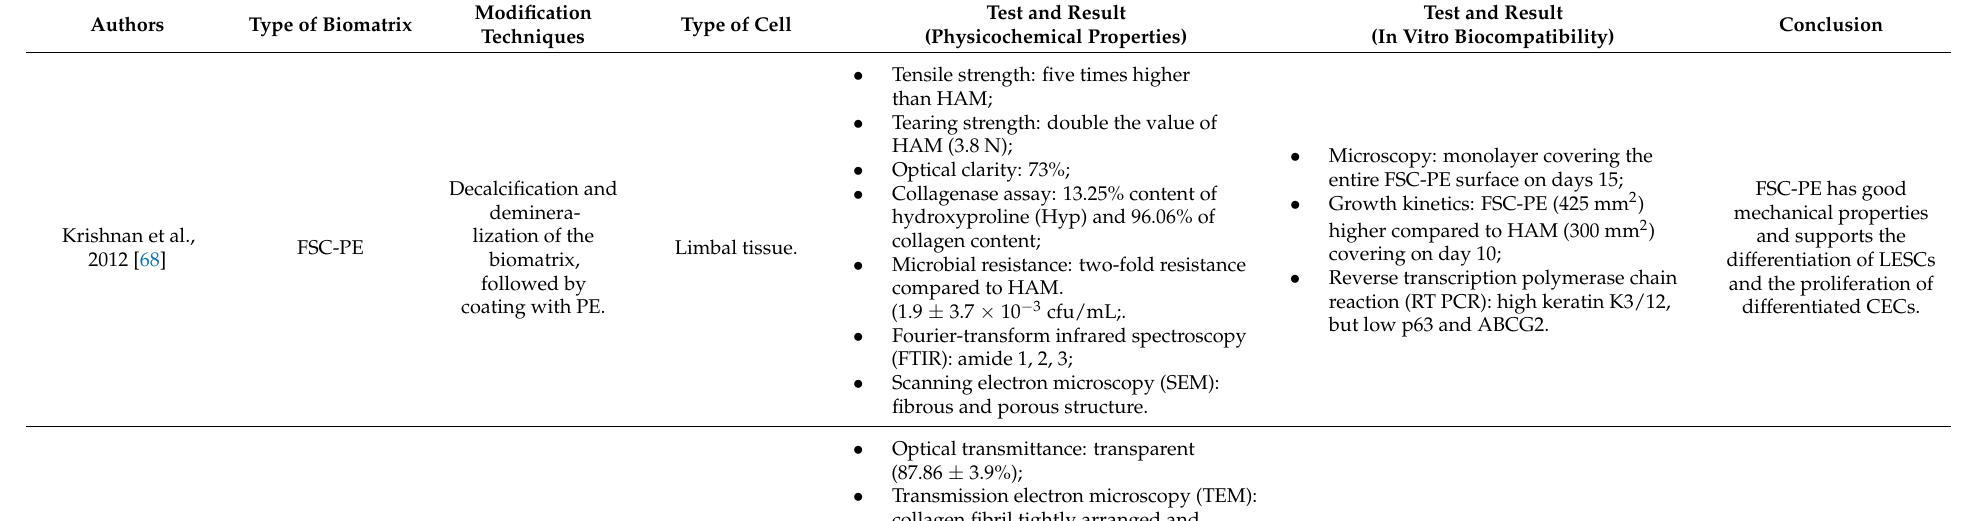
Table 1. Description of selected in vitro studies on the modified collagen